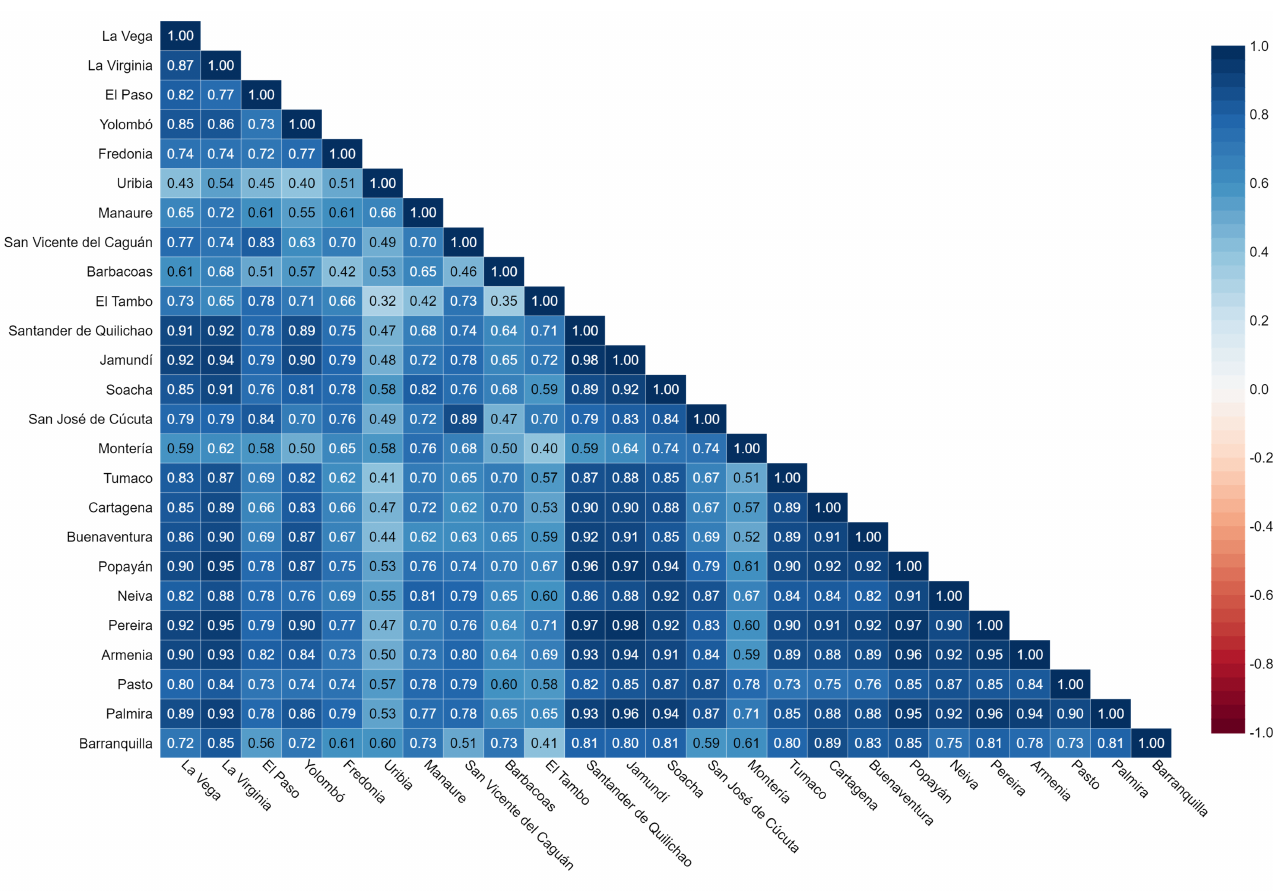
Figure 7. The correlation matrix reflects the linear relationship between 25 municipalities in Colombia for the period from 1 March 2020, to 19 May